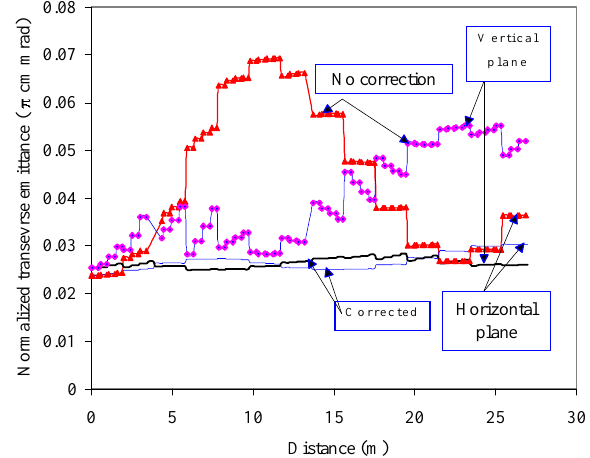
FIG. 11. (Color) Proton beam deflection angle in 115 MHz QWRs calculated by the simplified equations (6)–(8) (solid curves) and ray-tracing code TRACK (dotted curves).